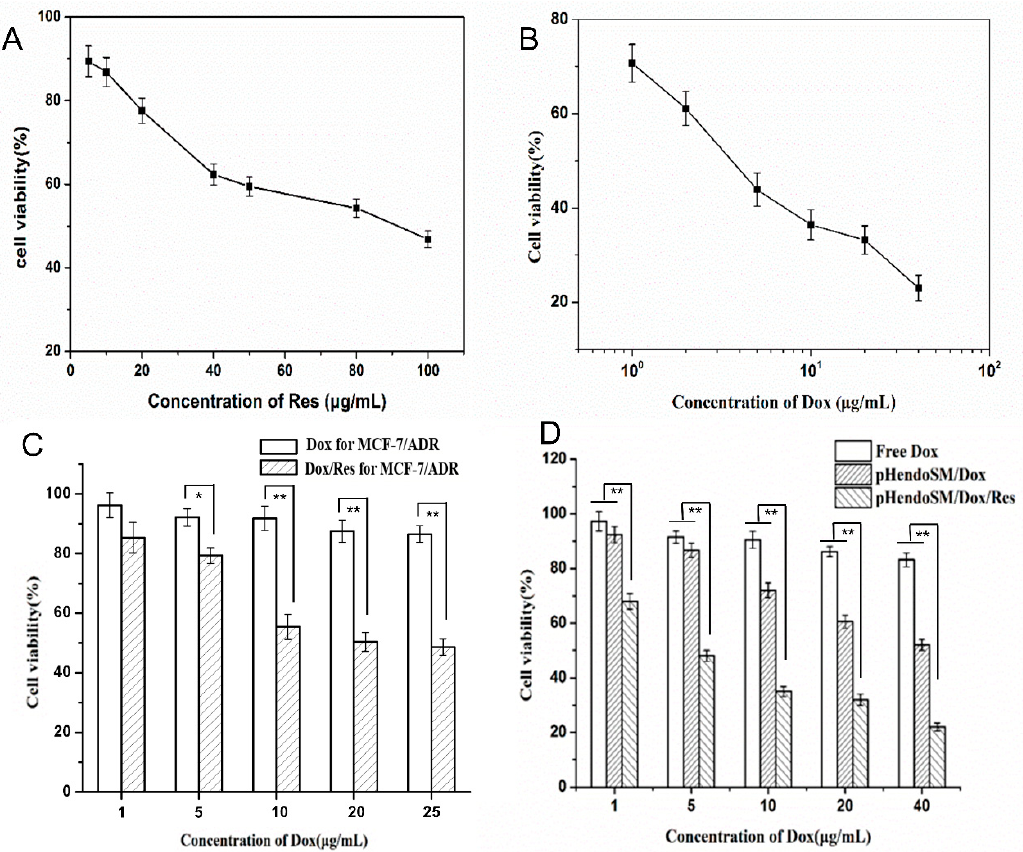
Figure 3. In vitro cytotoxicity of free Res ( A ), free Dox ( B ), combination of different proportions of Dox and Res (The concentration of Res was kept at 10 μ g/mL) ( C ). pH-endoSM/Dox and pH-endoSM/Dox/Res ( D ). All experiments were tested on MCF-7/ADR cells after 48 h incubation. Cell viability (%) was expressed as a percentage compared to the untreated control cells. All data are expressed as mean values ± SD of 5 independent experiments, * p < 0.05, ** p < 0.01 compared with the control group.